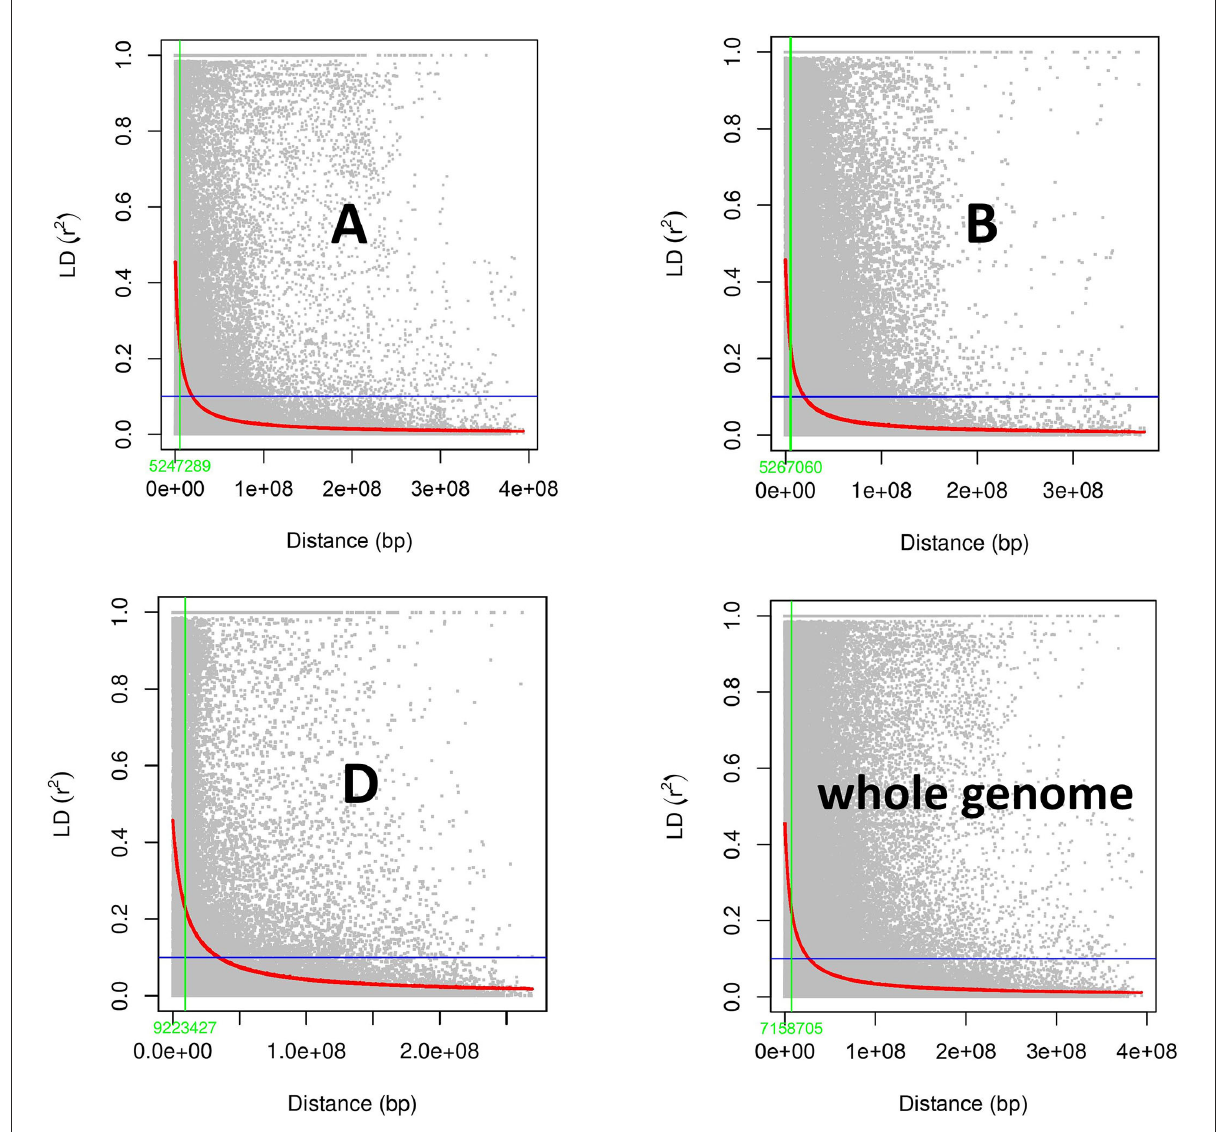
FIGURE5 Subgenome and whole genome-wide linkage disequilibrium (LD) decay in GWAS panel of 282 diverse bread wheat